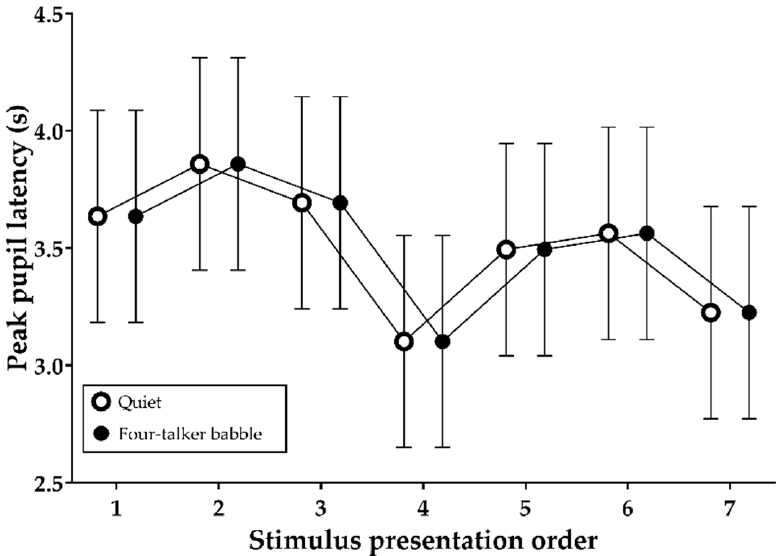
Figure 7. Mean and 95% confidence intervals of peak pupil latencies in the quiet and four-talker babble conditions as a function of stimulus presentation order.